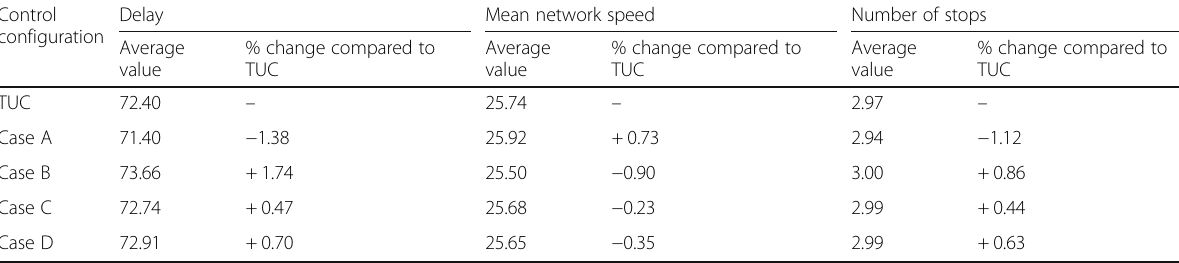
Table 1 Simulation results for demand scenario 1 (light traffic conditions) Control configuration